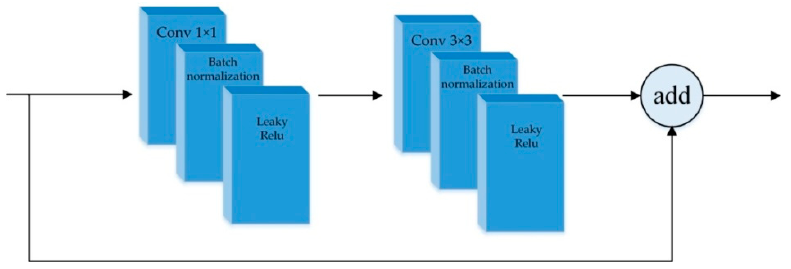
Figure 1. The structure of the Residual unit.